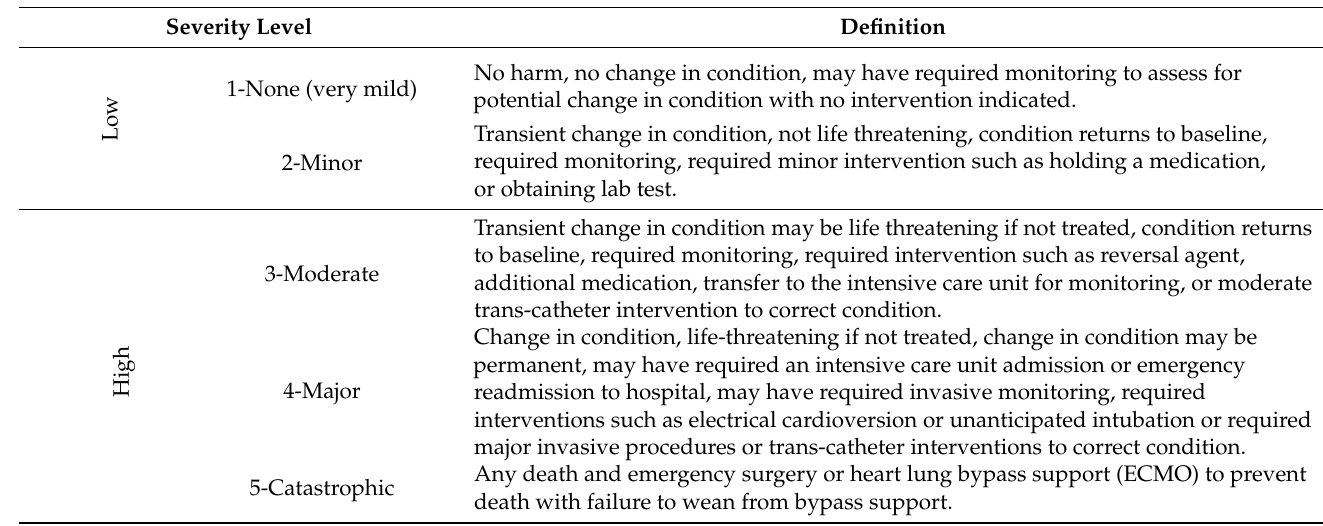
Table 1. Adverse event severity scale.